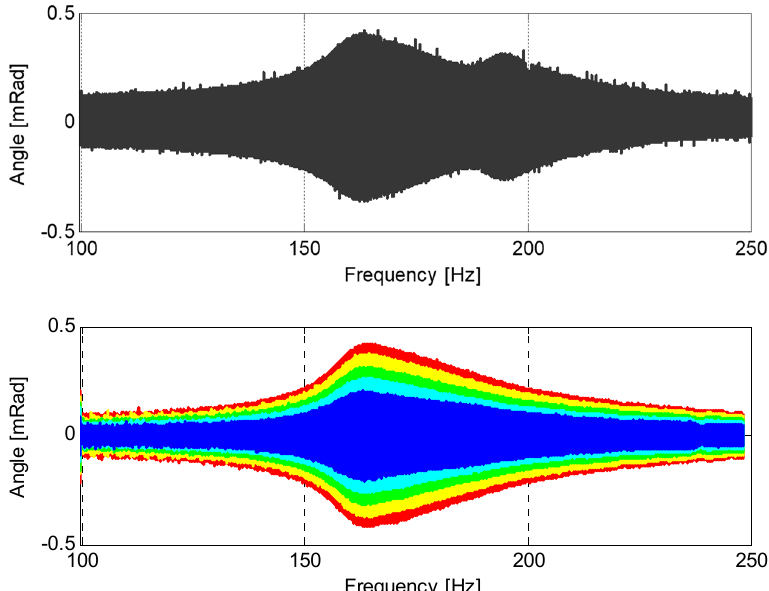
Figure 23. The results of RC testing. Standard RC test results are at the top; the results from the additional accelerometers are at the bottom. Material: saclSi 1; Isotropic pressure 100 kPa; Frequency spectrum 100–250 Hz; Excitation (torque) amplitude 2 V (– original built-in sensor, – the top sensor, S1, – the second sensor from the top, S2, – the third sensor from the top, S3, – the fourth sensor from the top, S4, – the bottom sensor, S5).